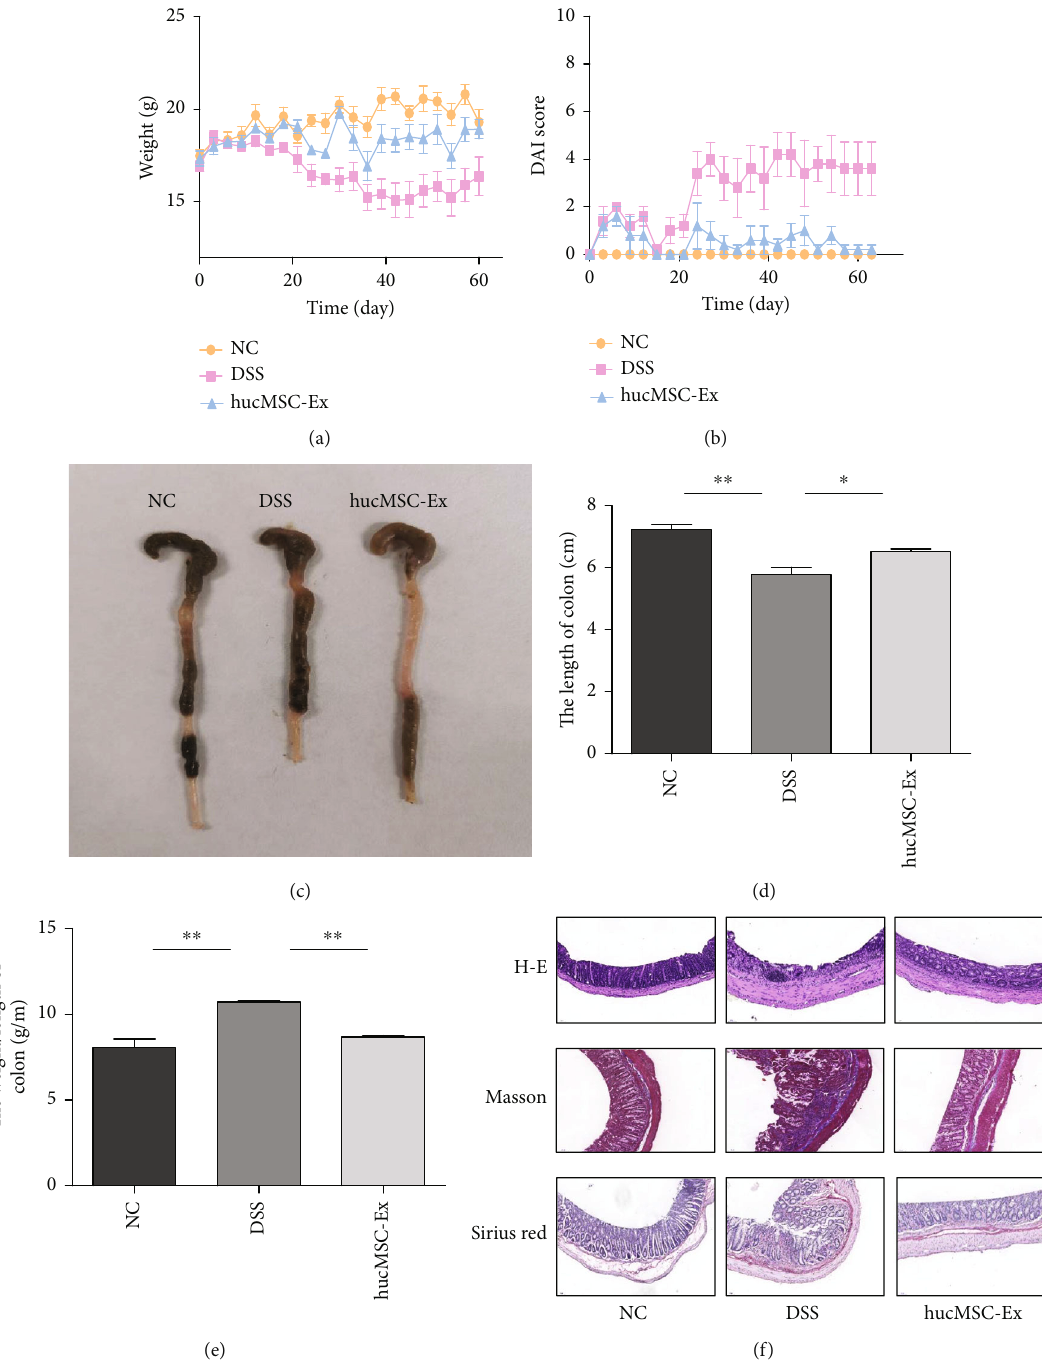
Figure 2: hucMSC-Ex alleviates DSS-induced IBD-related intestinal fi brosis in mice. (a) Weights of mice. (b) DAI scores of mice. (c) Colon appearance in mice. (d) Statistical chart of mice colon length, ∗ P < 0 : 05 and ∗∗ P < 0 : 01 . (e) Weight/length ratio of mouse colon, ∗∗ P < 0 : 01 . (f) H&E, Sirius red, and Masson staining of mouse colon